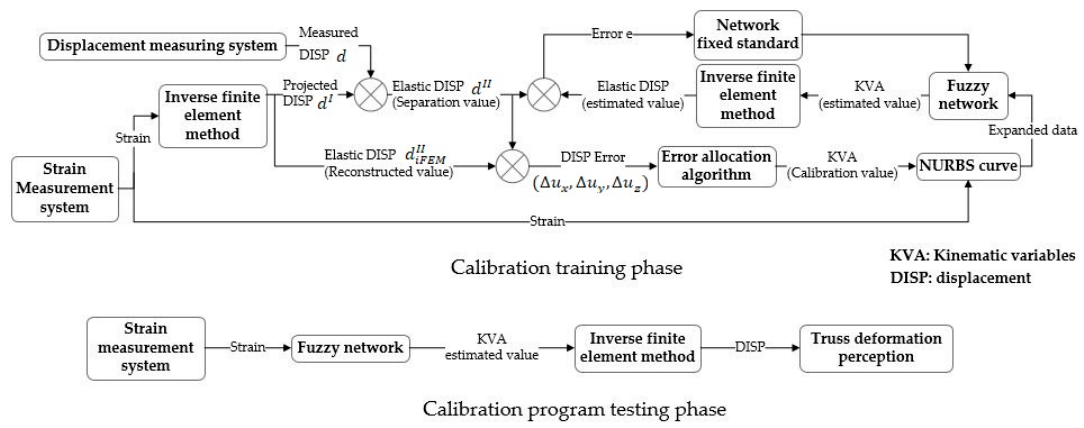
Figure 4. Block diagram of two-step calibration algorithm.